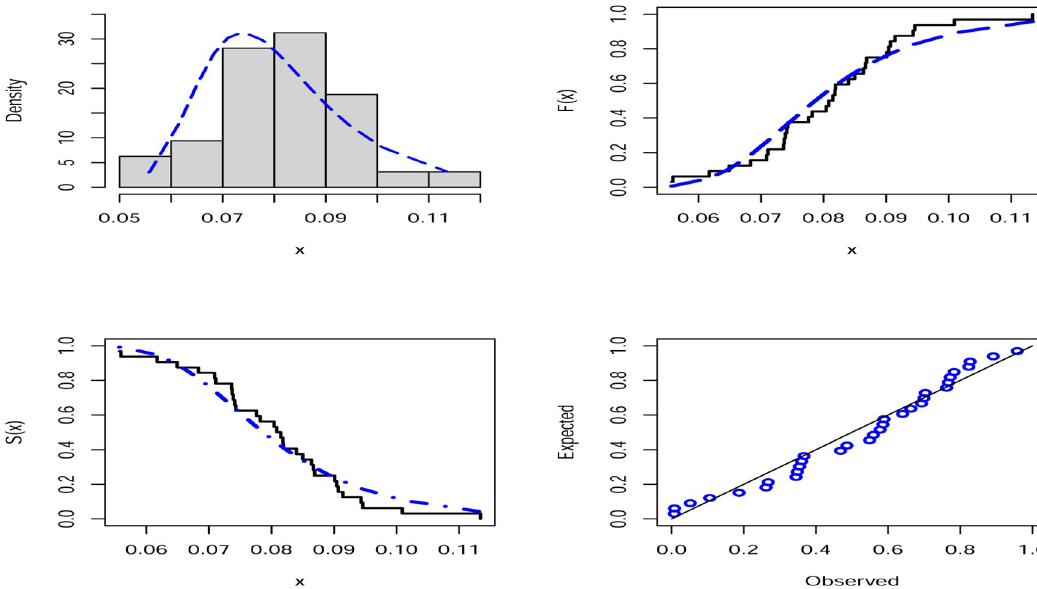
Fig 5. Histogram of the first COVID-19 real data set with the fitted PDF, CDF, SF and P-P plots.